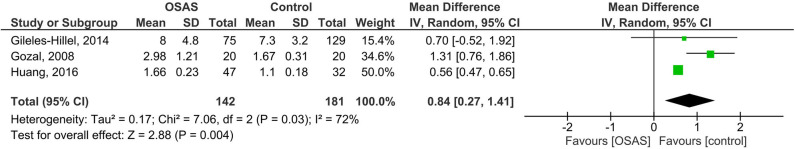
Forest plot of random-effects analysis of plasma interleukin-6 levels in children. The diamond shape indicates the pooled mean difference (MD). Each black box represents a point estimate of each study and also gives a representation of the study size (the bigger the box, the more participants in the study). A horizontal line representing the 95% confidence intervals (CIs) of the study result, with each end of the line representing the boundaries of CI. SD, standard deviation; OSAS, obstructive sleep apnea syndrome.